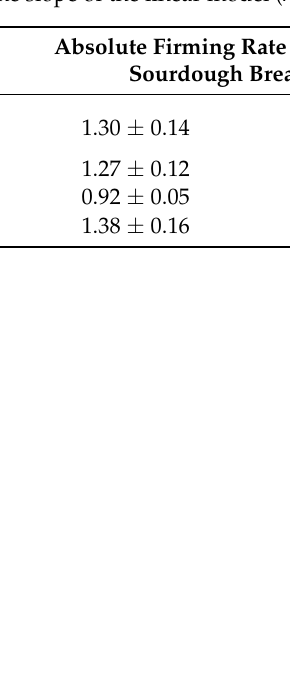
Figure 2. Normalized bread firmness as a function of the storage time depending on the storage conditions applied. Filled symbols and solid lines represent pan wheat bread samples, open symbols, connected by dashed lines, represent mixed-type sourdough bread samples. ( ■ ) Bread box at room temperature (BB), ( ● ) PE-layered microperforated paper bag at room temperature (LP), ( ▲ ) plastic bag at room temperature (PR) and ( ▼ ) plastic bag fridge temperature (PF). Normalized firmness of the crumb over storage time was fitted using a linear model. Table 4. Firming rates for different storage conditions and bread types after normalization. The results are shown in the table in terms of the firming rate, defined as the slope of the linear model ( x(cid:3364) ± STD, n = 3). Norm. Firming Rate of Pan Wheat Norm. Firming Rate of Mixed-Type Bread (N/d) Sourdough Bread (N/d) PE-layered microperforated paper bag 0.46 ± 0.07 (R² = 0.84) (21.3 ± 0.4 °C) (R² = 0.93) Plastic bag (21.9 ± 0.5 °C) 0.26 ± 0.03 (R² = 0.92) 0.24 ± 0.01